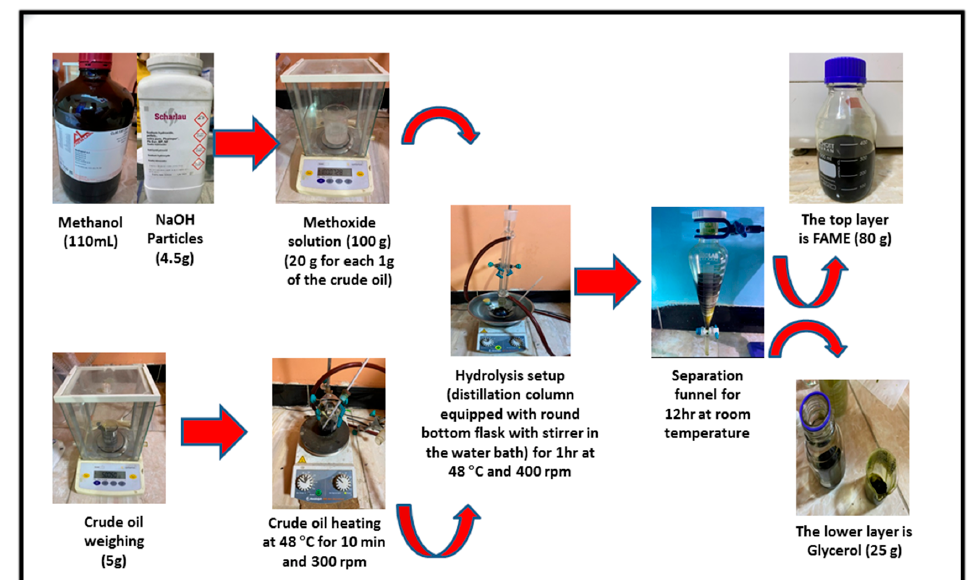
Figure 2. Experimental images for the procedure of hydrolysis of the crude oil of Chlorella Vulgaris microalgae.